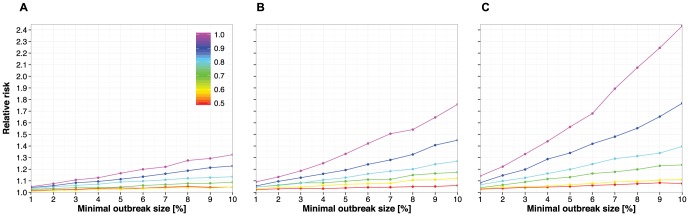
Probability of disease outbreaks that involve at least a given fraction of the susceptible population for contact networks with positively assortative vaccination status relative to contact networks with randomly distributed vaccination status.Networks were constructed by adding a vaccination status to all nodes of the contact network at 90 CPR that was measured at the high school in 2010. Simulations used 100 networks with randomly distributed vaccination status and 100 networks with positively assortative vaccination status (assortativity index r = 0.1 at 90 CPR). Relative risks of outbreaks (vertical axes) are defined as the ratio of the median of the vaccine assortative networks' outbreak probabilities to the median of the outbreak probabilities in random networks and are based on 10,000 simulation runs for each network setting. Minimal outbreak size (horizontal axes) are defined as percent of the susceptible population, which is the number of unvaccinated individuals plus the number of vaccinated individuals times the complement of the assumed vaccine efficacy (1−VE). Thus, each point on the colored lines represents the difference in probability of a disease outbreak based on the ratios between randomly and positively assortative networks for a given minimal outbreak size, and for different vaccine efficacies of 0.5, 0.6, 0.7, 0.8, & 1.0, and assuming: (A) 40%, (B) 50%, and (C) 60% vaccination coverage.